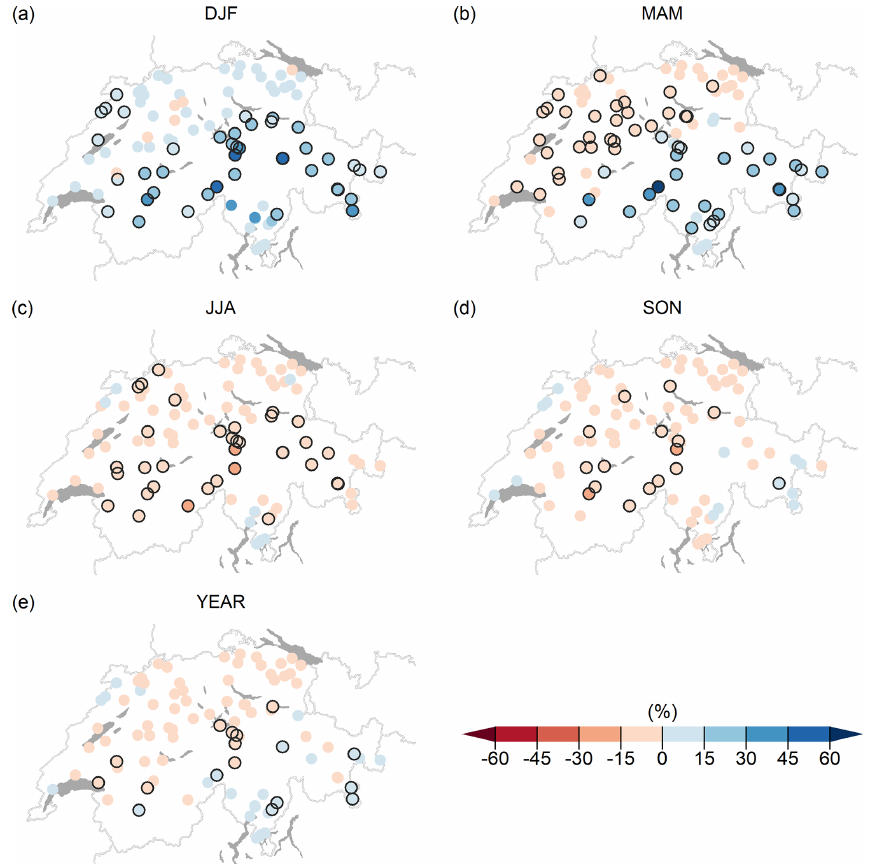
Figure 3. Equivalent to Fig. 2 but with projections for RCP2.6.